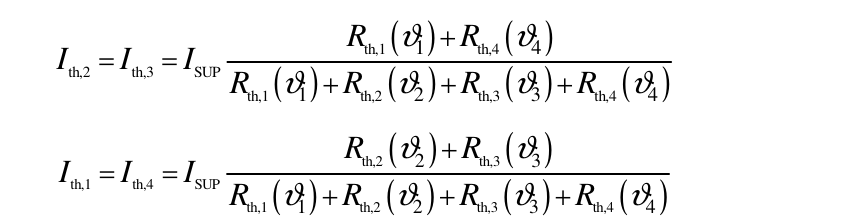
and U are flow B SUP